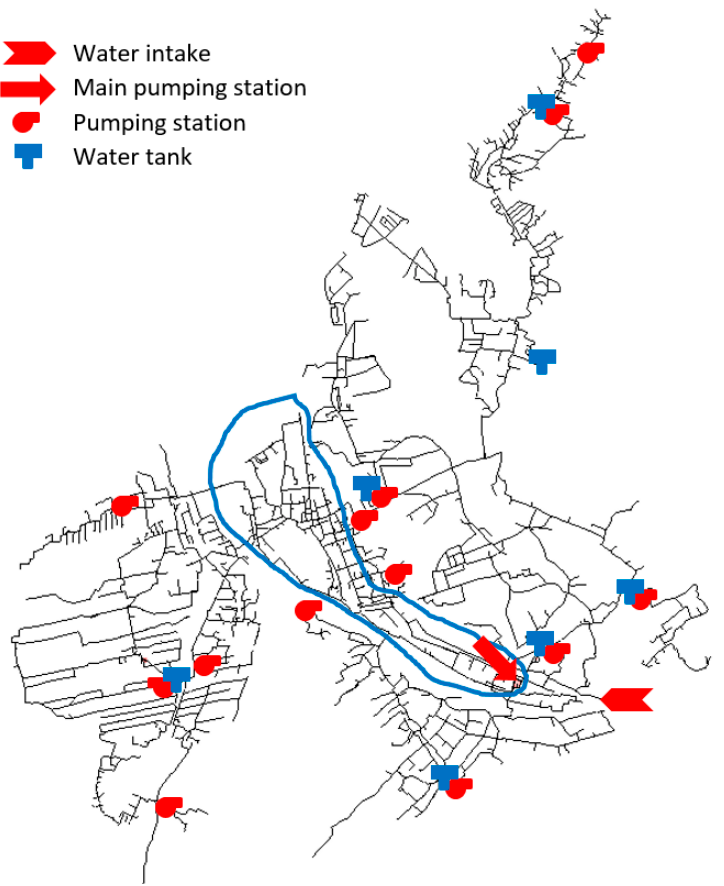
Figure 3. Geometric structure of the water supply network along with the location of the water intake, pumping station, and water tanks. The blue line designates the analysed zone.